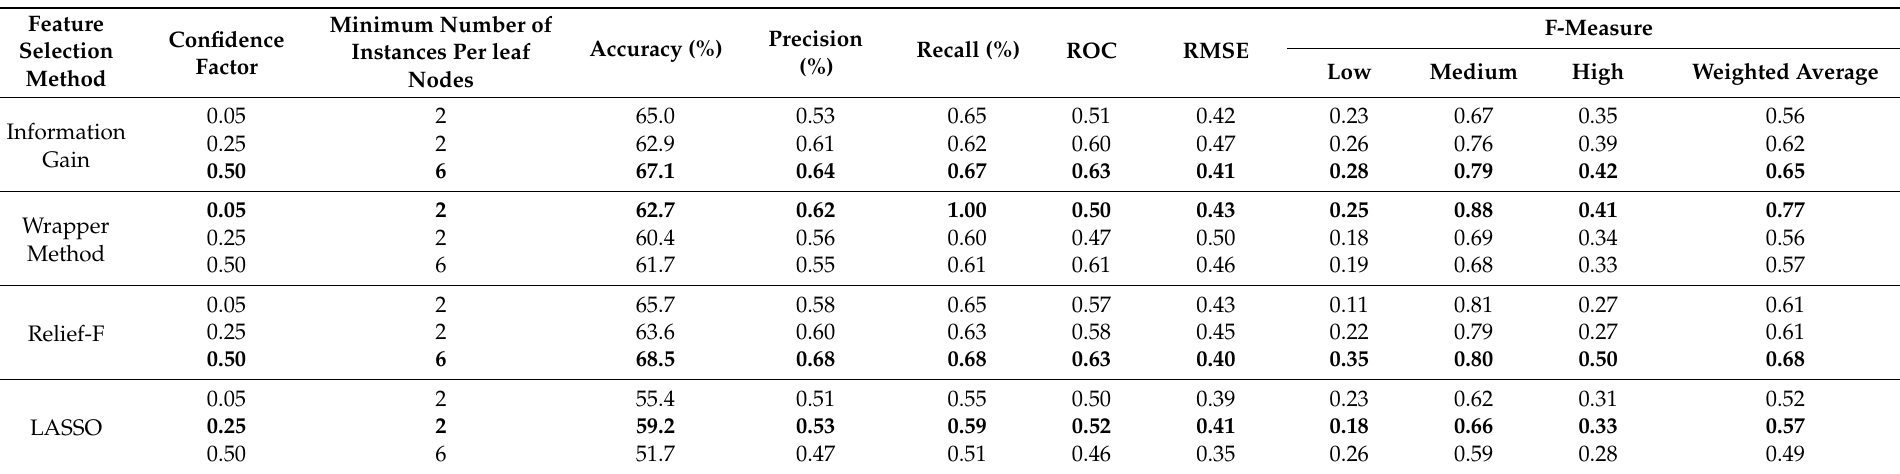
Table 4. Performance of J48 classifier through various feature selection